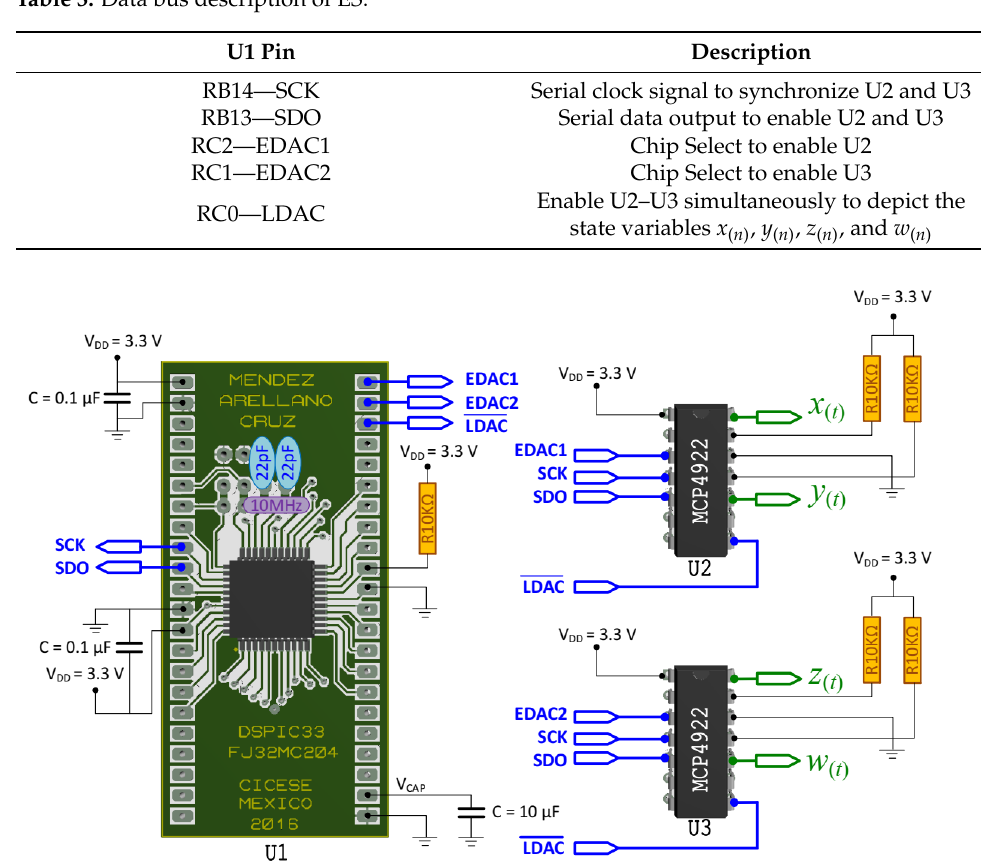
Table 3. Data bus description of ES.